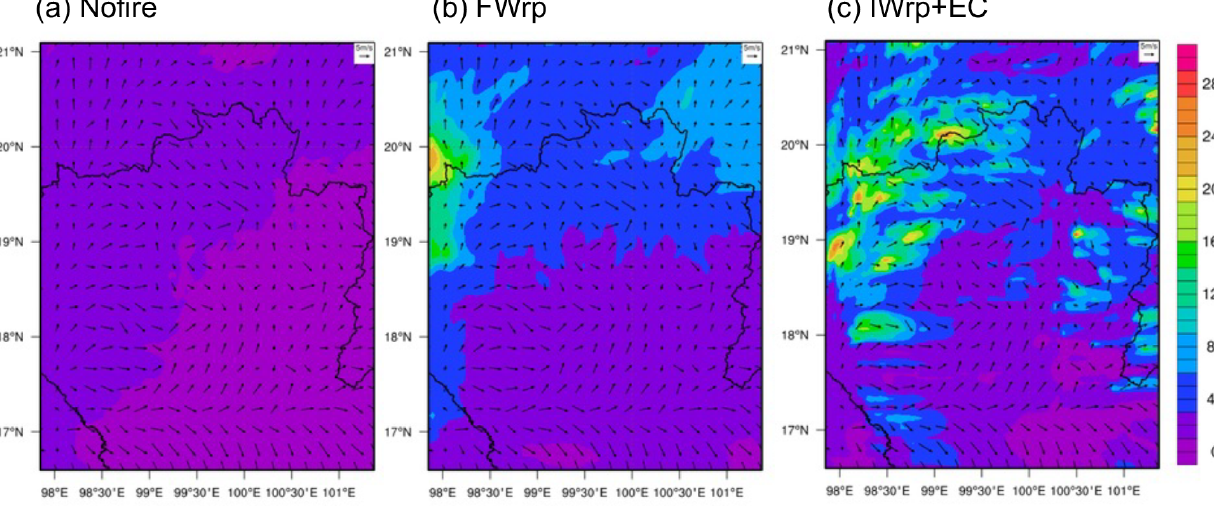
Figure 8. Spatial distribution of near-surface PM 10 concentration on 19 March 17:00LST over burning regions of nPSEA for the fourth domain